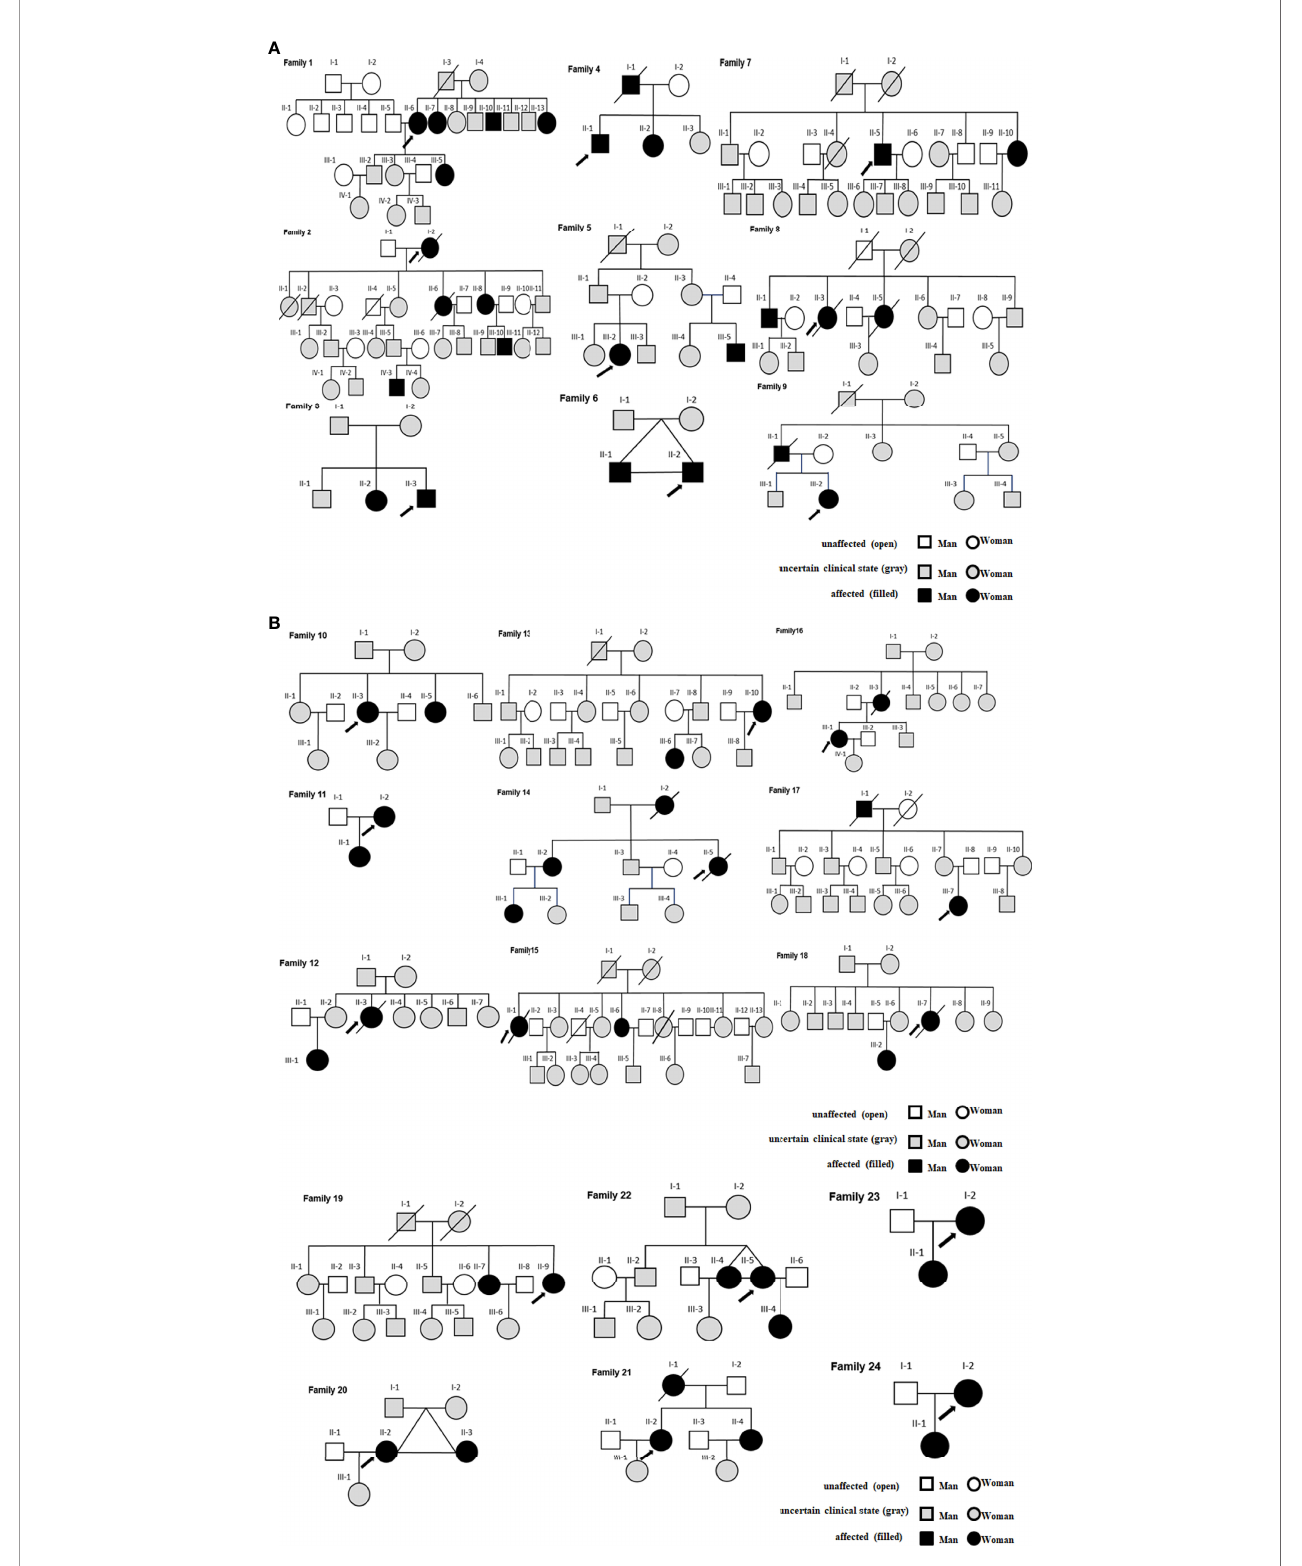
FIGURE 3 | (A) Class 1-SLE families. (B) Class 2-SLE